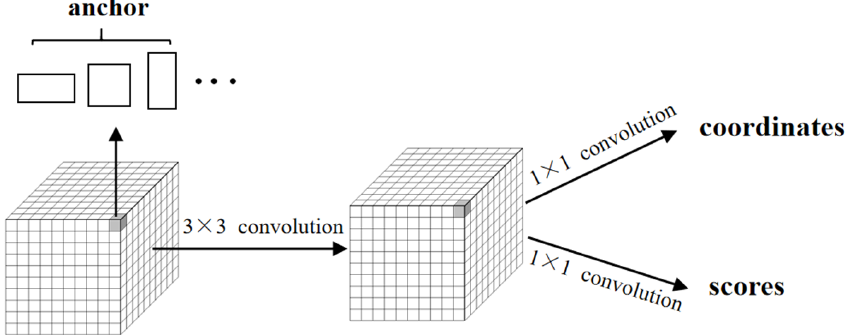
Figure 1. The schematic framework of RPN (regional recommendation network).